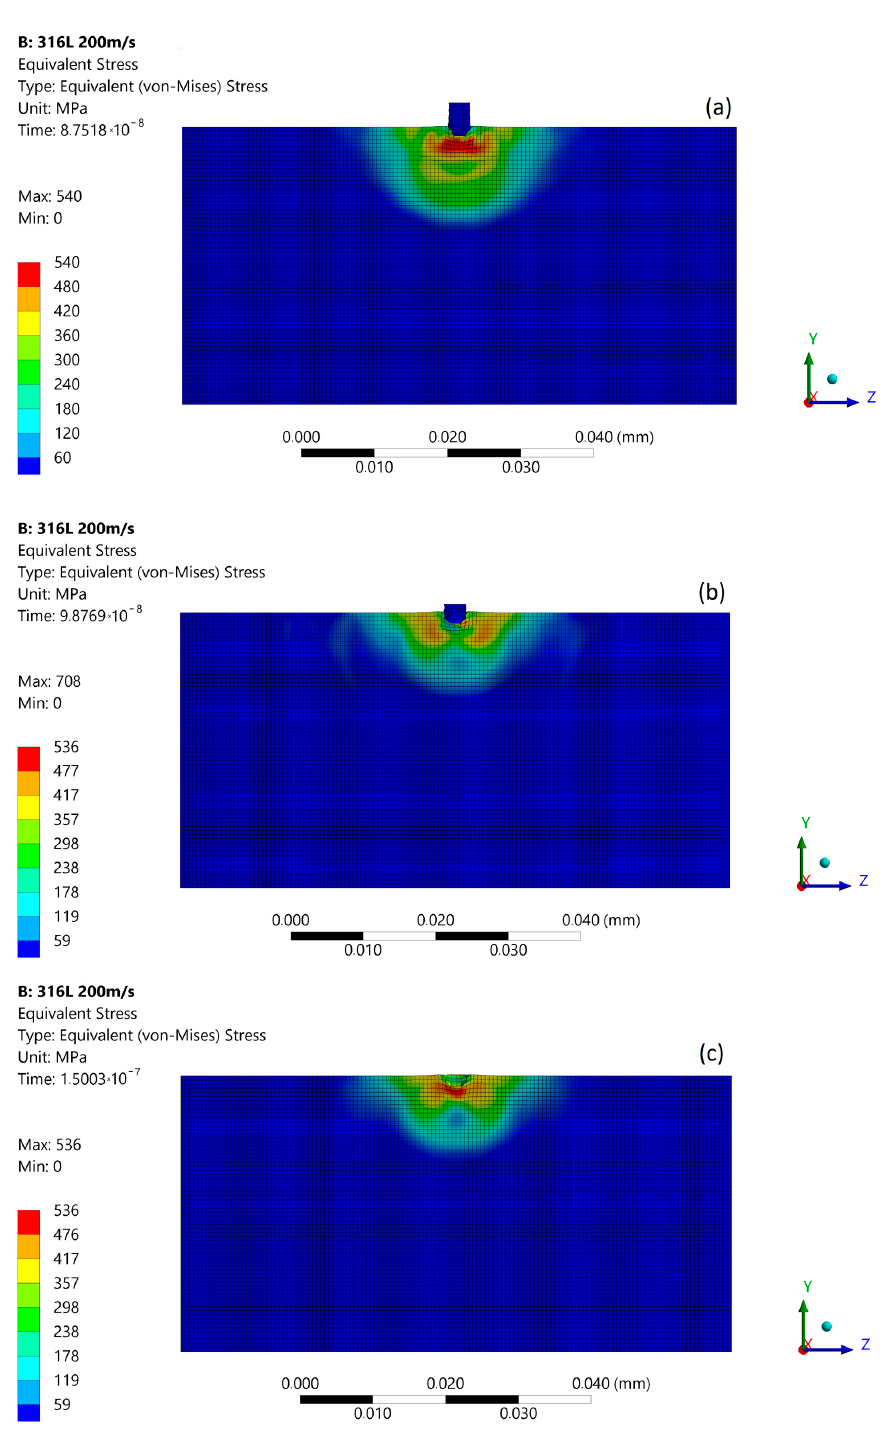
Figure 10. Von Mises stress distribution during subsequent micro-jet impact at 200 m/s: ( a ) initial stage of the impact; ( b ) stage during the impact; ( c ) residual stress after the